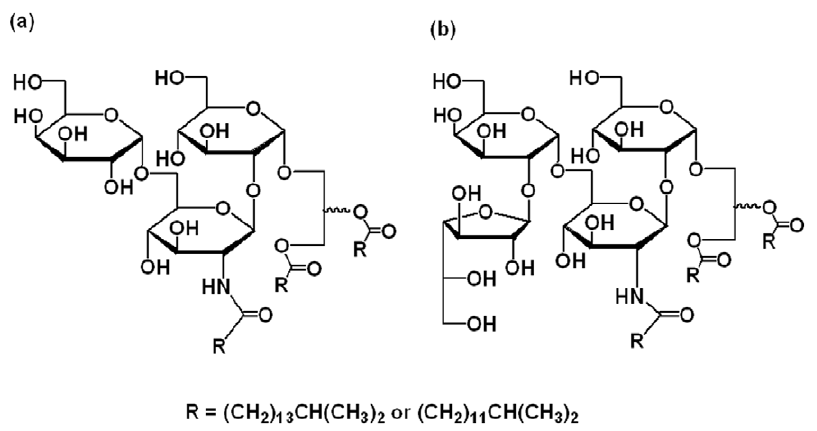
Figure 1. Proposed structures of neutral glycolipids from T.thermophilus HB8. (a) NGL-A; (b) NGL-C.